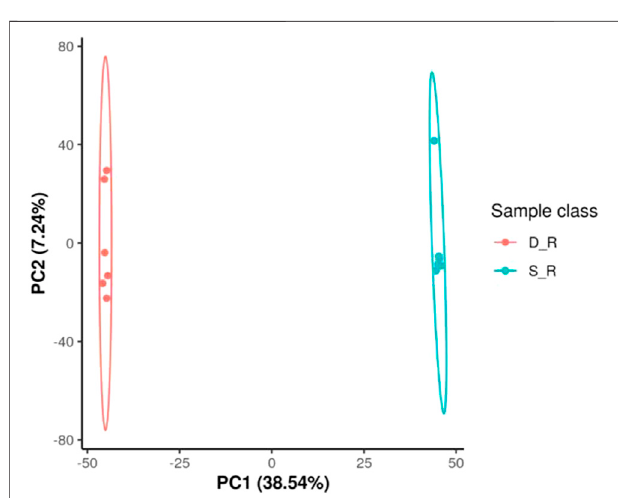
FIGURE11| Rootmetabolomevariationamongsamplesasdetermined by principal component analysis (PCA). a Positive electrospray ionization (ESI) mode, b negative ESI mode; PC1 represents the fi rst principal component; PC2 represents the second principal component. D_R, double-head root; S_R, single-head root; QC, quality control (a mixture of experimental samples prepared in equal amounts). The data shown are the means of six biological